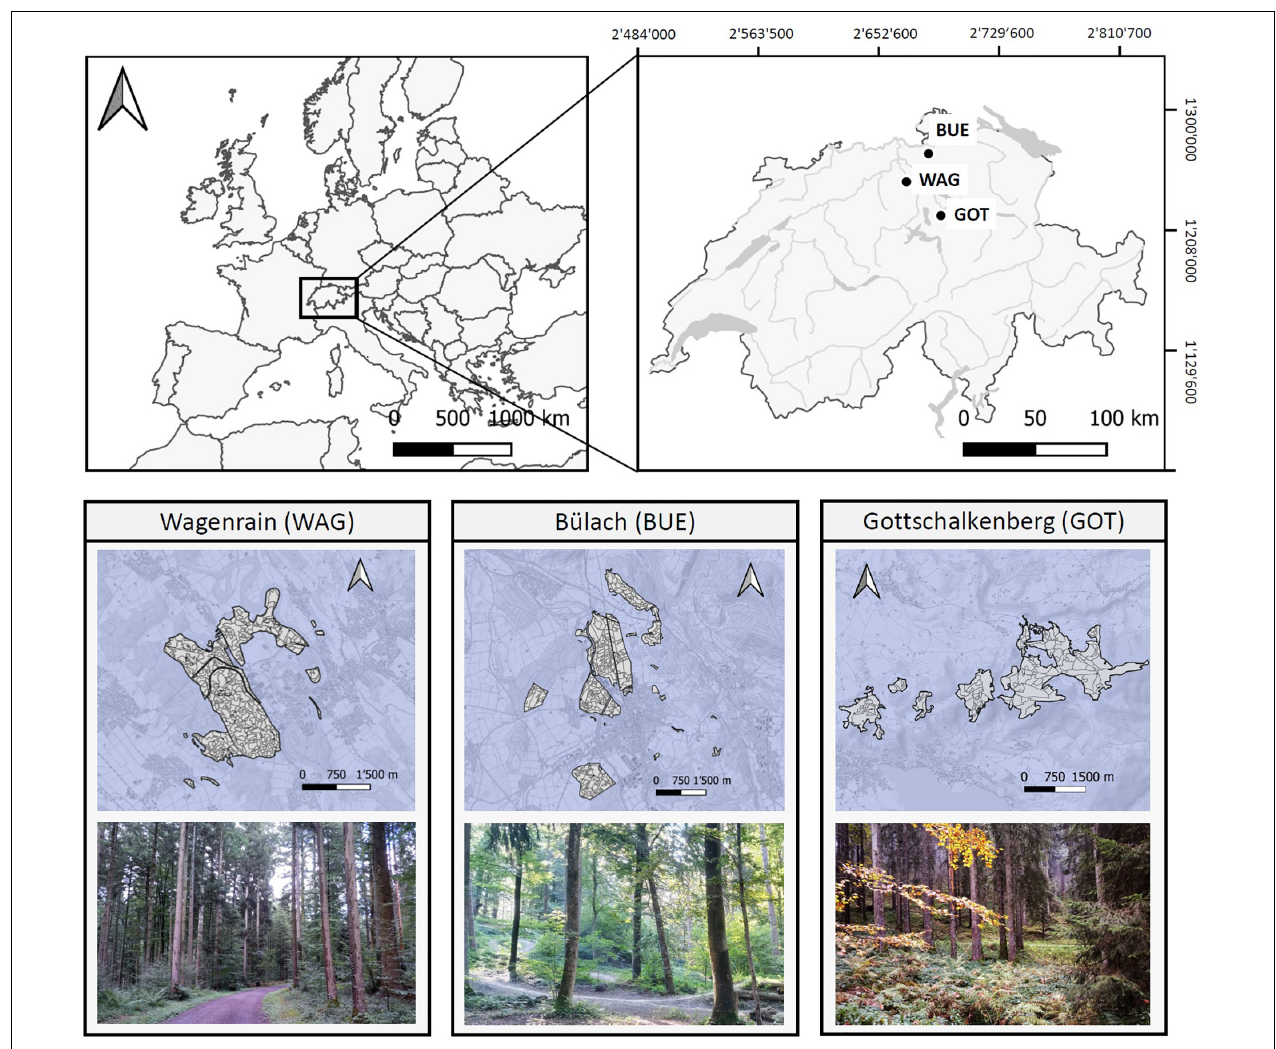
FIGURE 1 | Location of the selected case study enterprises (CSEs) in